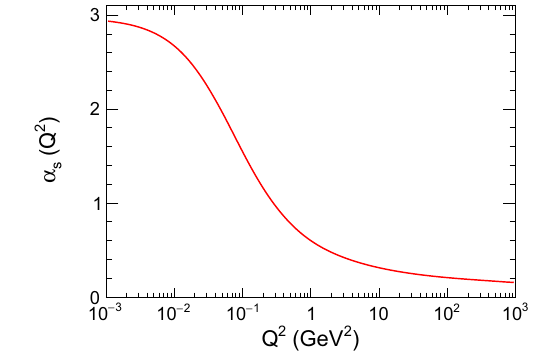
Fig. 1 The infrared-saturating strong coupling α s [43] used in this work